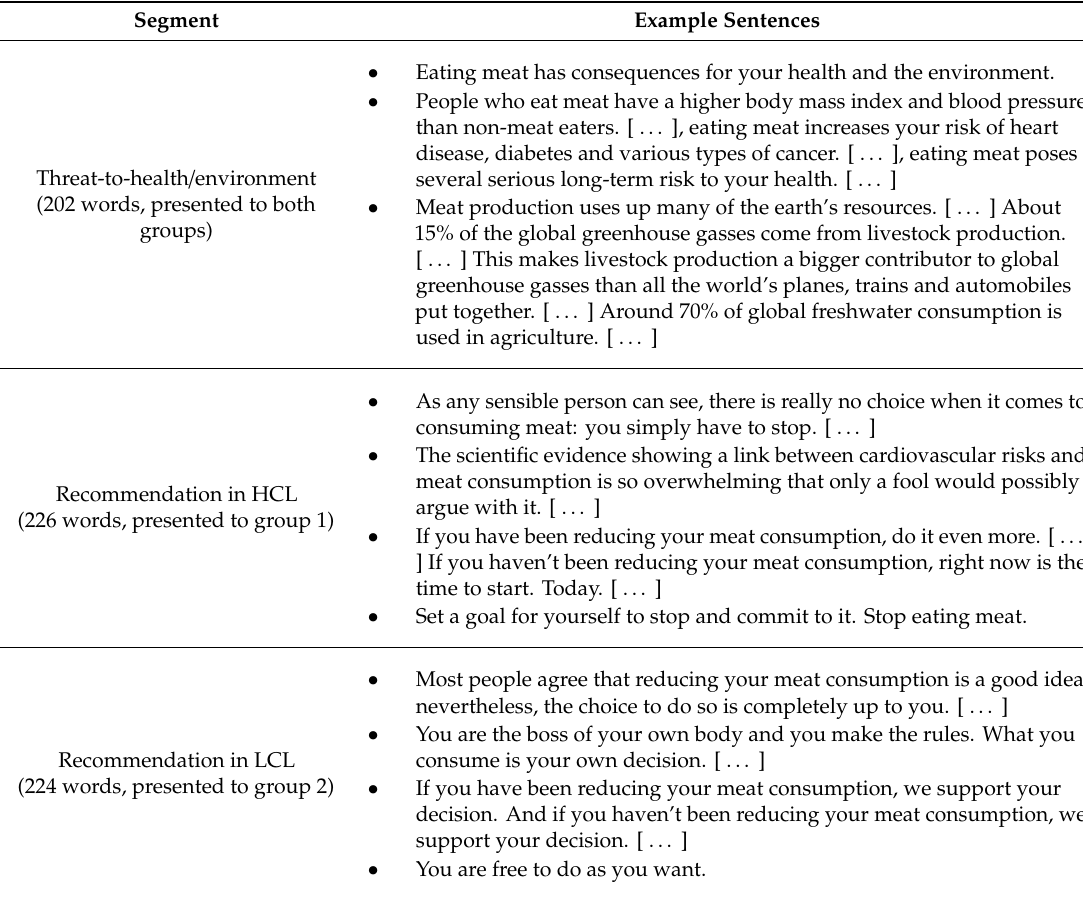
Table 1. A subset of sentences from the manipulation video advocating limited meat